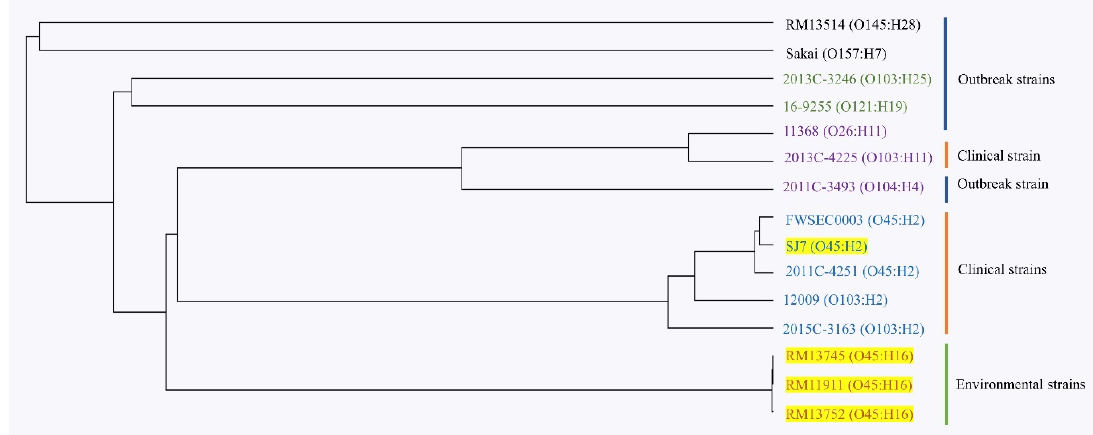
Figure 2. Whole-genome multilocus typing-based phylogenetic analysis of three environmental E. coli O45:H16 strains (RM13745, RM11911, and RM13752) and one clinical E. coli O45:H2 strain (SJ7) with eleven reference strains. The phylogenetic tree indicates five distinct clusters, with the strain names shown in black color for cluster 1, green color for cluster 2, purple color for cluster 3, blue cluster for cluster 4, and orange color for cluster 5. The strains highlighted in yellow were sequenced this study. The sources of isolation (outbreak, clinical, and environmental) for these 15 strains are indicated right next to the strain names.